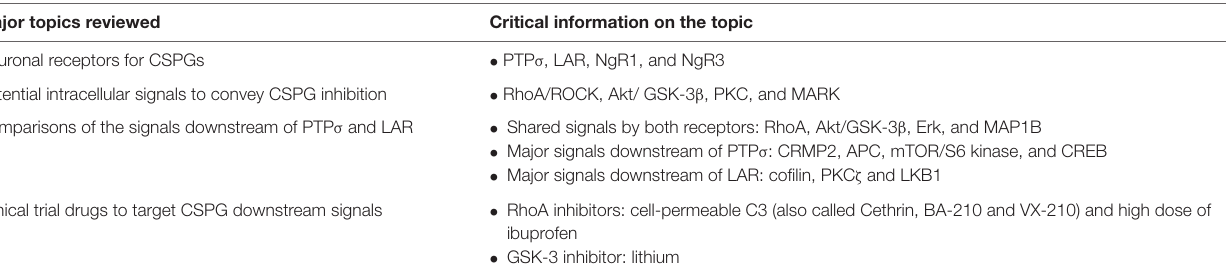
TABLE 1 | Summary of the major topics reviewed in this